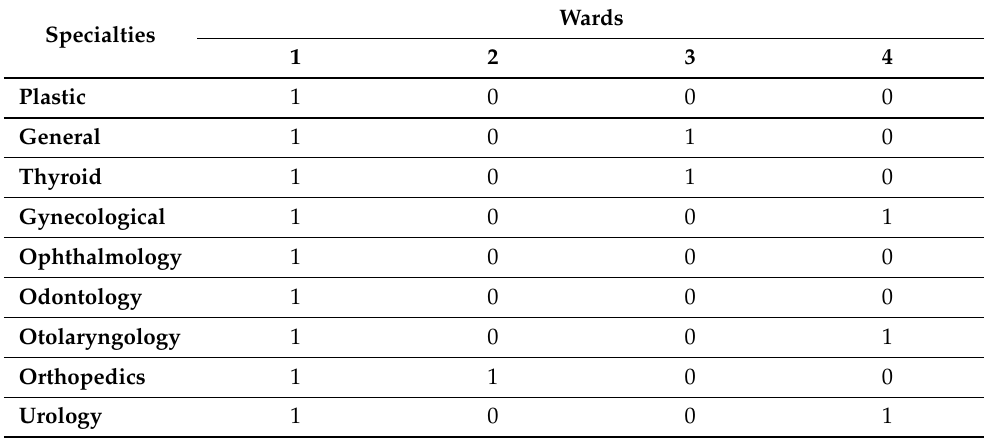
Table 2. Misplacement matrix D sw